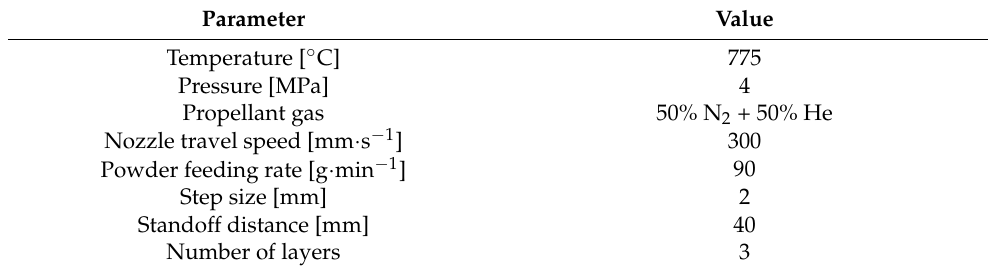
Table 1. Parameters of the cold-spray processes.